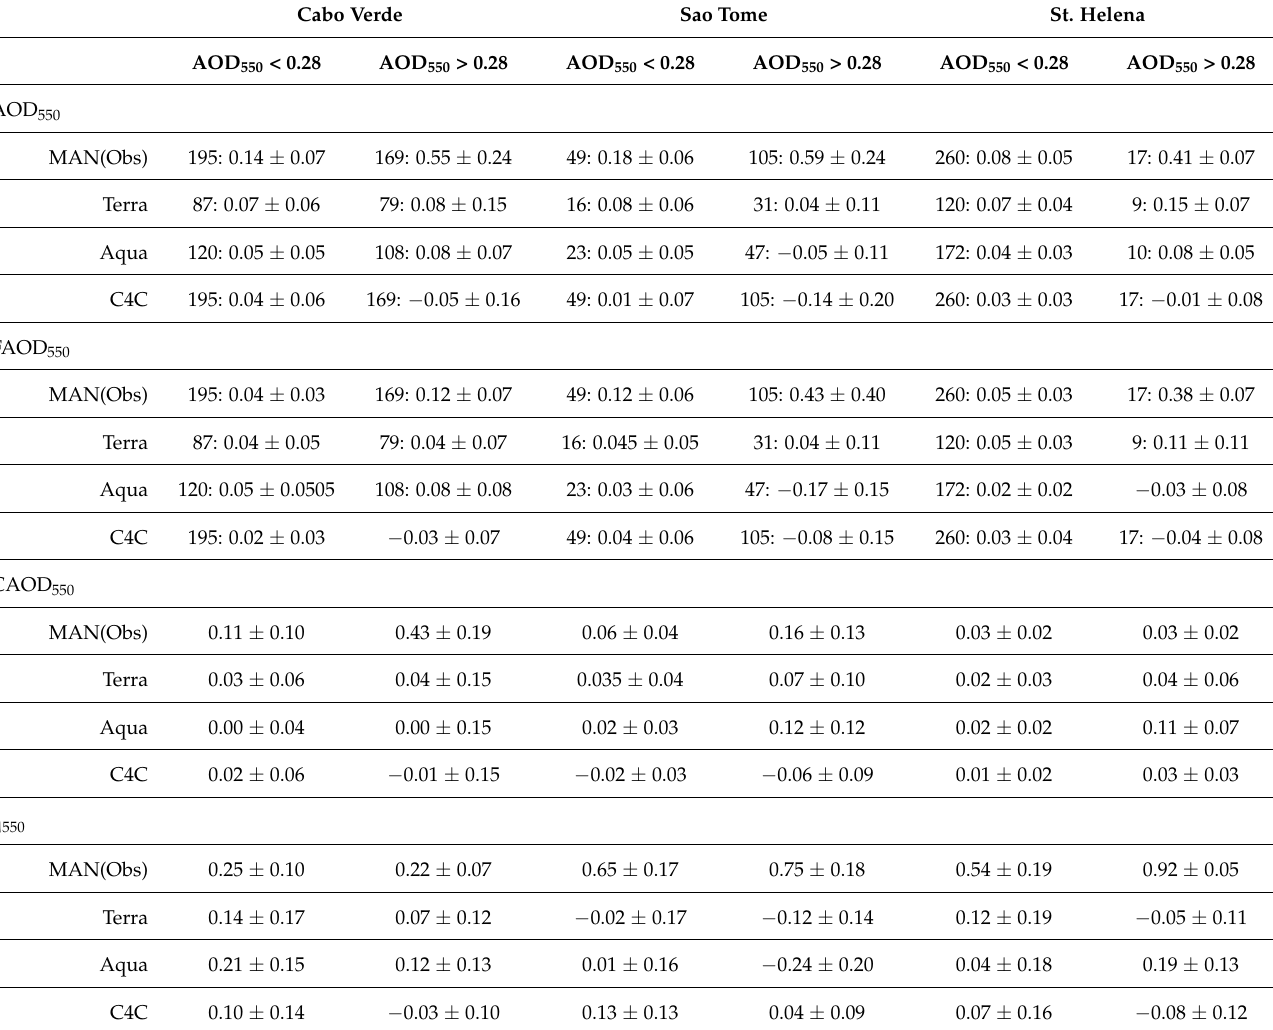
Table 6. Diagnostic error mean bias+root mean square deviation (RMSD) for Terra and Aqua MODIS and the C4C consensus for three AERONET sites representing the west coast of Africa. Left columns, Cabo Verde sampling the Saharan dust plume dominated (16.7 ◦ N, 22.9 ◦ W); middle columns, Sao Tome representing the Sahel and Gulf of Guinea with a mixture of mixed dust, biomass burning and pollution (0.4 ◦ N, 6.7 ◦ E); and right columns, St. Helena, dominated central Africa (~15.9 ◦ S, 5.7 ◦ W). The AERONET observation means + standard deviations are also